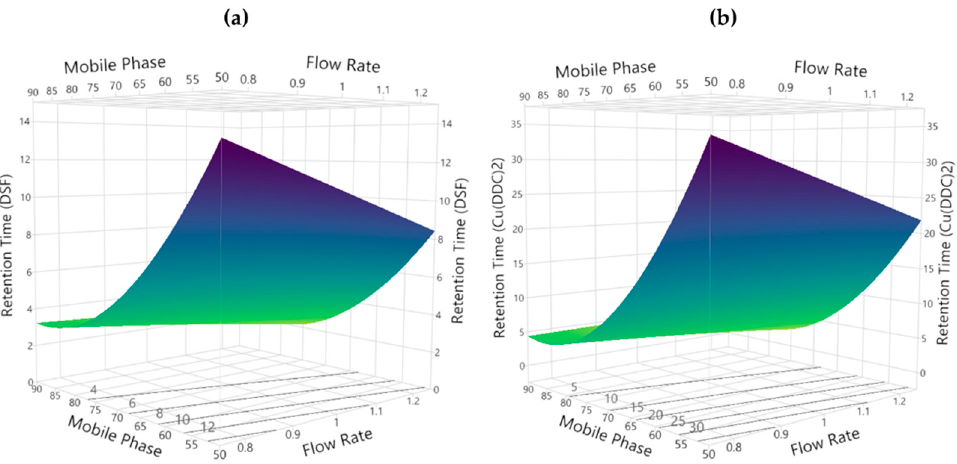
Figure 8. Three-dimensional response surface plot for the effect of flow rate (X 1 ) and mobile phase composition (X 2 ) on DSF ( a ) and Cu(DDC) 2 ( b ) retention time.